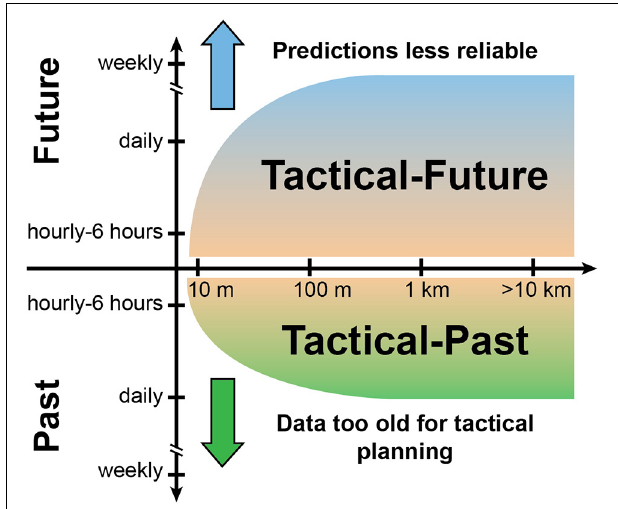
FIGURE 2 | Schematic showing the timeline associated with the usefulness of Earth Observing, modeling, and forecast products. The older the product the less useful it becomes for tactical planning. Different uses will likely require products with different horizontal resolutions (horizontal axis) and